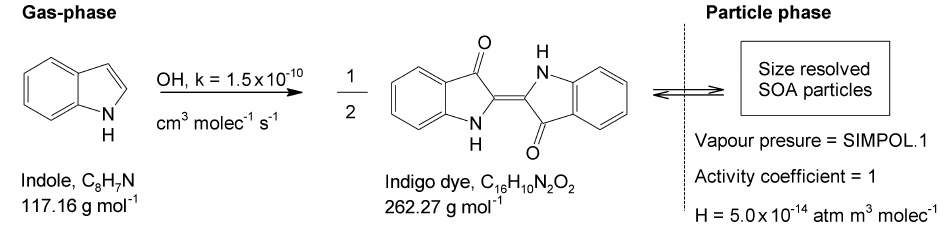
Figure 2. Summary of modifications made to the UCI-CIT model chemical mechanism and aerosol modules. In the simulation that included oxidation by NO 3 an additional similar reaction was added with the indole + NO 3 rate constant of 1 . 3 × 10 − 10 cm 3 molec − 1 s − 1